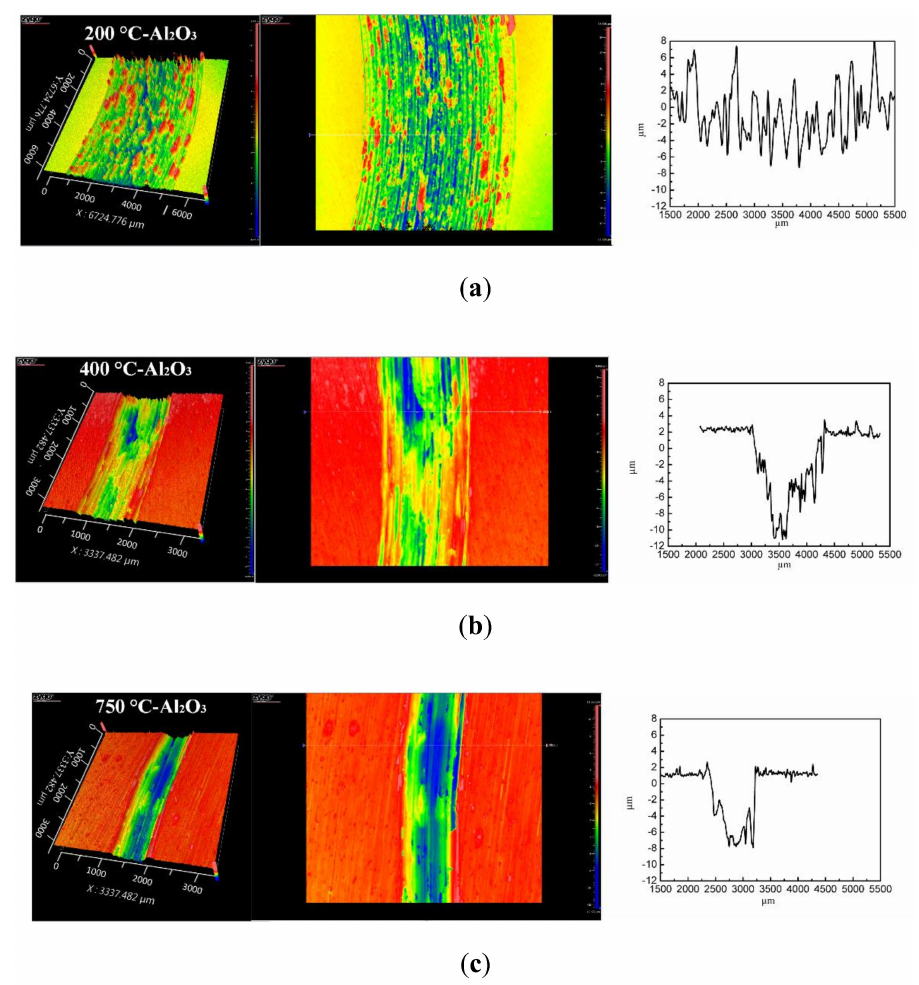
Figure 6. 3D images and profiles of the worn surfaces of the Ti-22Al-25Nb alloy vs. Al 2 O 3 at different